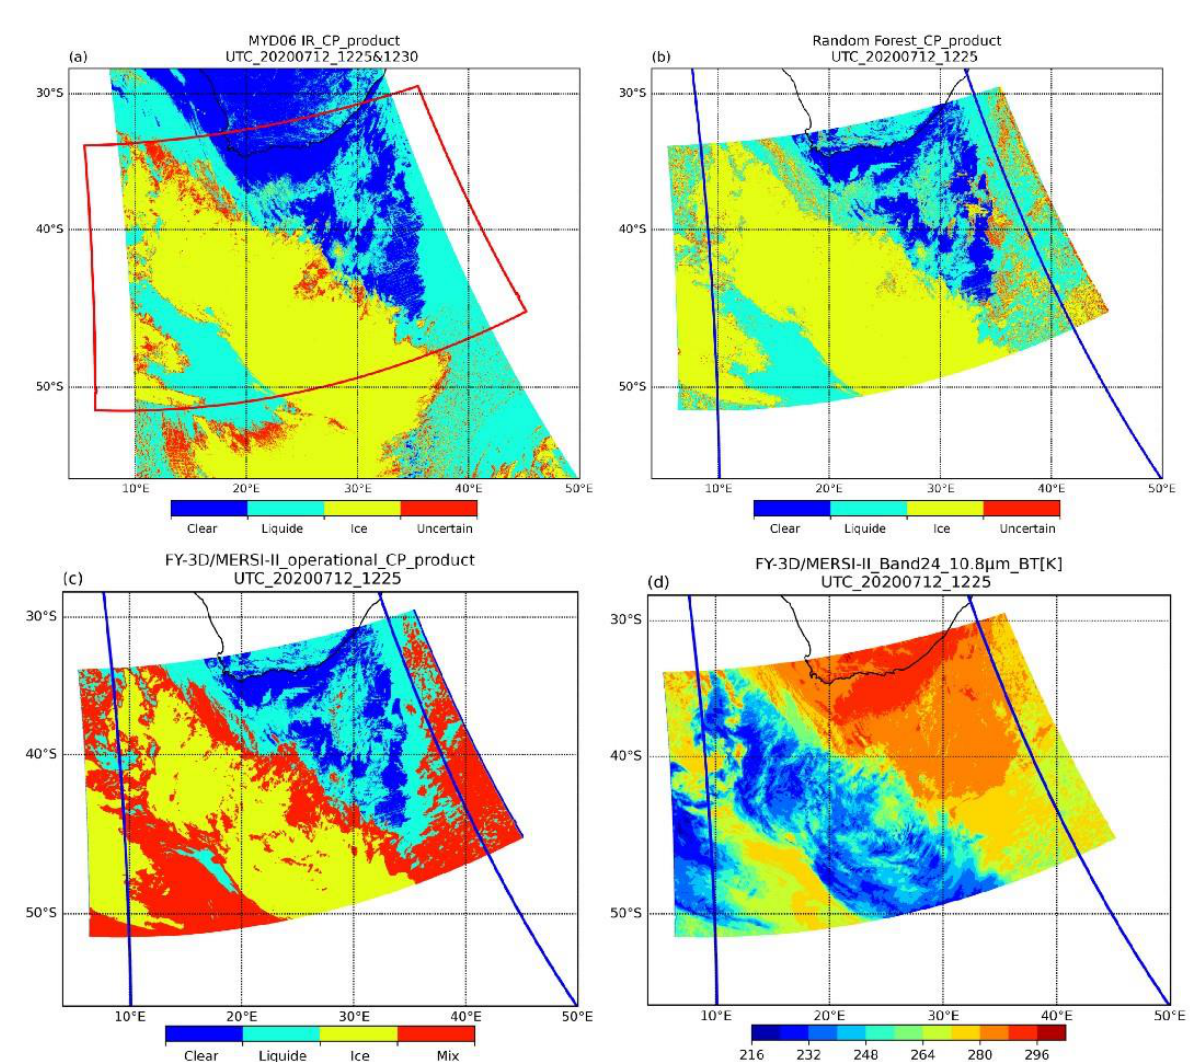
Figure 5. Comparisons of CP in mid-latitude winter (12 July 2020) for ( a ) the MODIS CP product at 12:25 and 12:30 UTC, ( b ) the RF CP product at 12:25 UTC, ( c ) the operational FY-3D/MERSI-II CP product at 12:25 UTC, and ( d ) the FY-3D/MERSI-II band 24 BT at 12:25 UTC. The red box is the outline of the 12:25 UTC FY-3D image, and the blue box is the contour of the 12:25 and 12:30 UTC Aqua images.